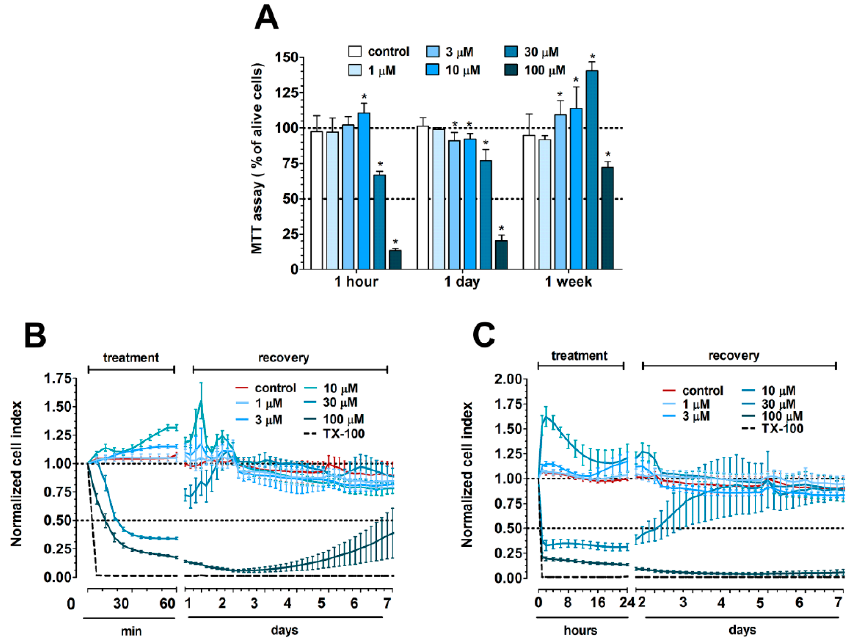
Figure 1. ( A ) MTT assay after 1-h treatment with PN159 peptide on Caco-2 cells followed by 1-h, 1-day or 1-week recovery. The MTT values are given as percent of the control group (100% viability). Values are presented as means ± SD, n = 3–8. Statistical analysis: analysis of variance (ANOVA) followed